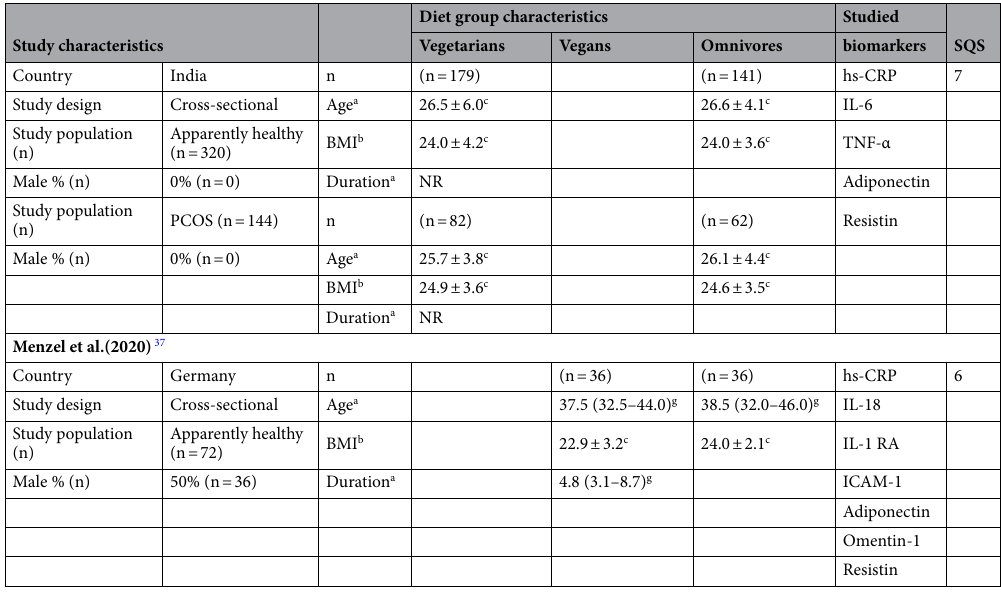
Table 1. Characteristics of reviewed studies on the association of vegan or vegetarian diet with inflammatory biomarkers. a Reported in years; b reported in kg/m 2 ; c expressed as mean ± SD; d mean ± SE; e mean ± SEM; f mean (95%-CI); g median (IQR); h using baseline values; i mean across both diet groups; SQS: Study Quality Score (using Newcastle—Ottawa Quality Assessment Scale adapted for cross-sectional studies); NR: not